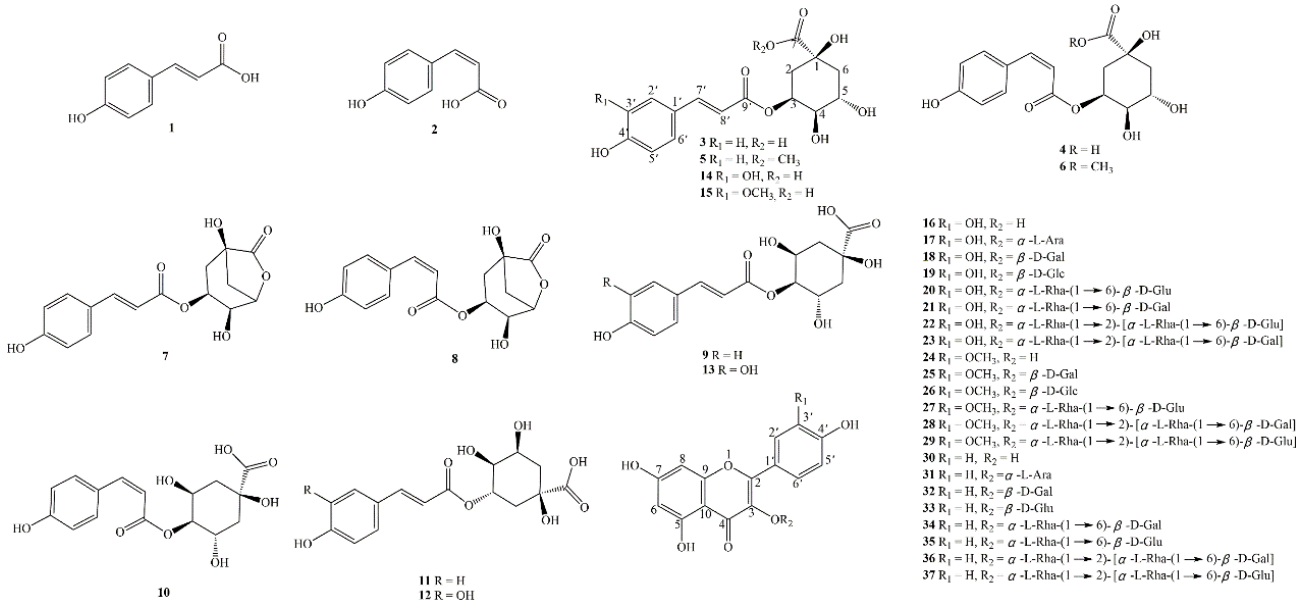
Figure 2. Structures of the isolated compounds.